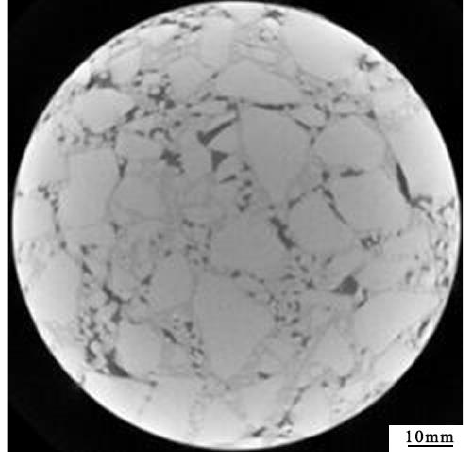
Figure 4. CT image of core sample for asphalt